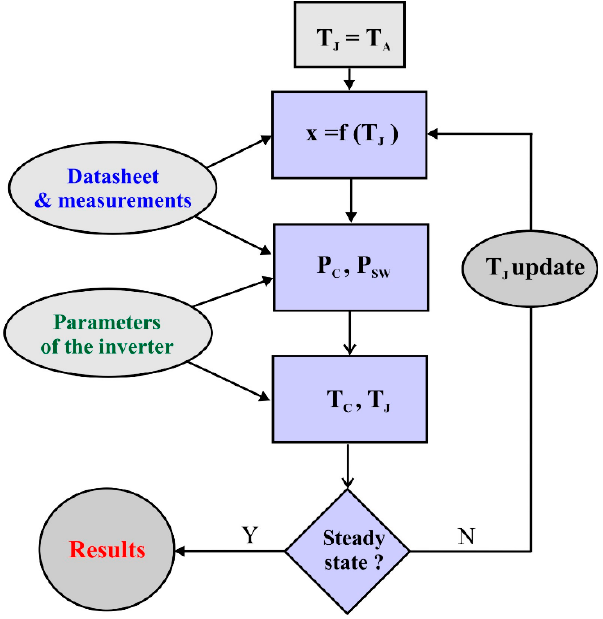
Figure 2. The diagram of the applied procedure to estimate power losses and junction temperatures.